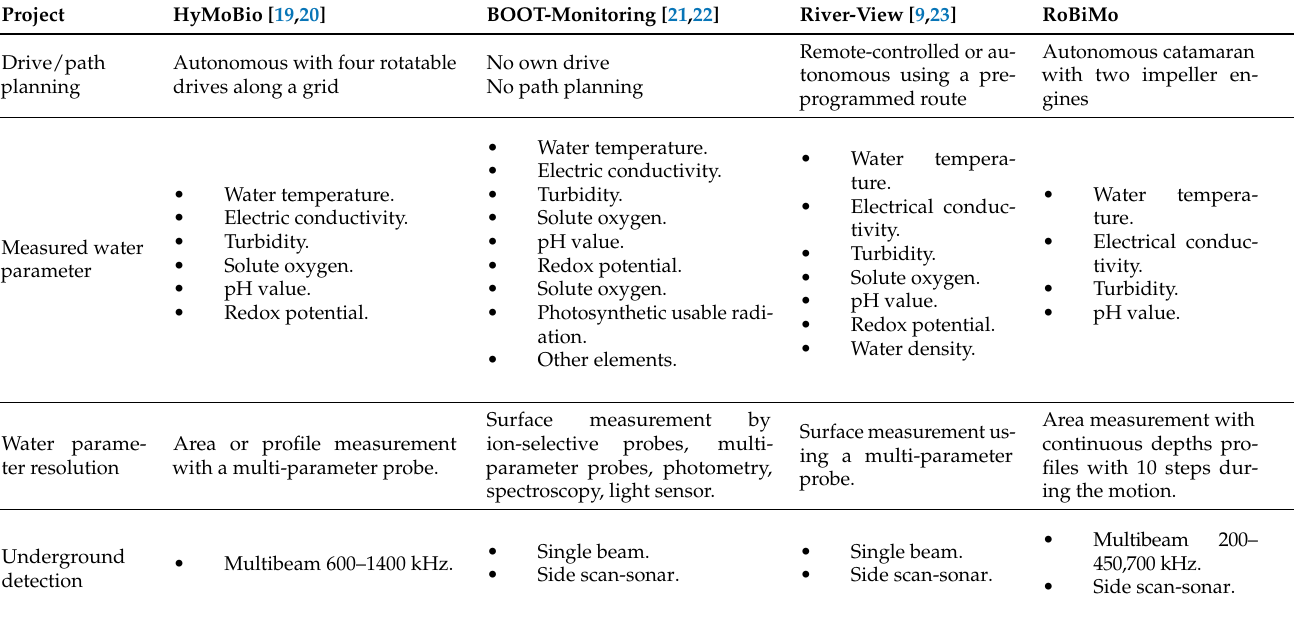
Table 1. Comparison of the projects HyMoBio, BOOT-Monitoring, and River View as ASV with water quality measurement and sea ground detection by an echo sounder